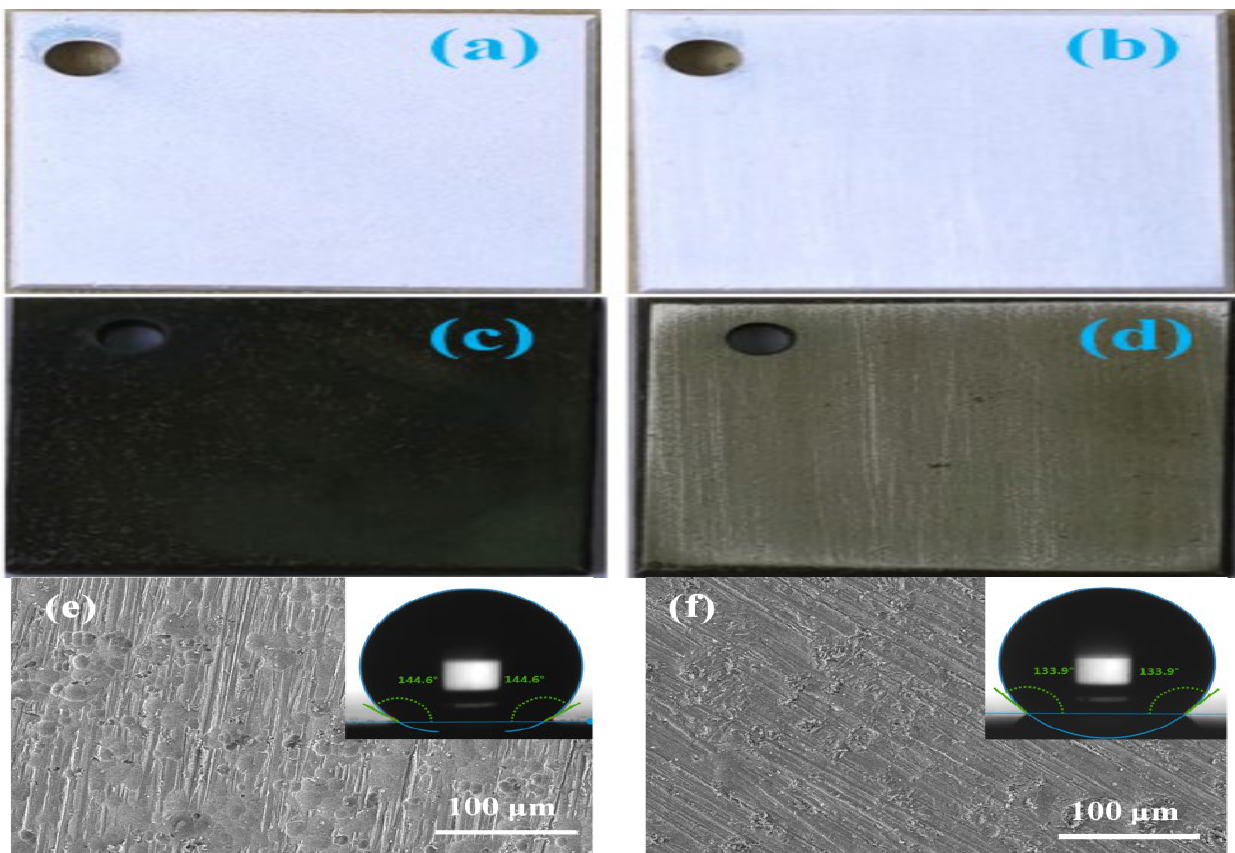
Figure 6. Digital images of ( a ) stearic-acid-treated sample after Na 2 CO 3 etching, ( b ) stearic-acid-treated sample after Na 2 CO 3 etching after abrasion test, ( c ) stearic-acid-treated sample after NaOH etching at 90 °C and ( d ) stearic-acid-treated sample after NaOH etching at 90 °C after abrasion test. SEM images of ( e ) stearic-acid-treated sample after Na 2 CO 3 etching after abrasion test, ( f ) stearic-acid-treated sample after NaOH etching at 90 °C after abrasion test. The inset is the image of the contact angle.